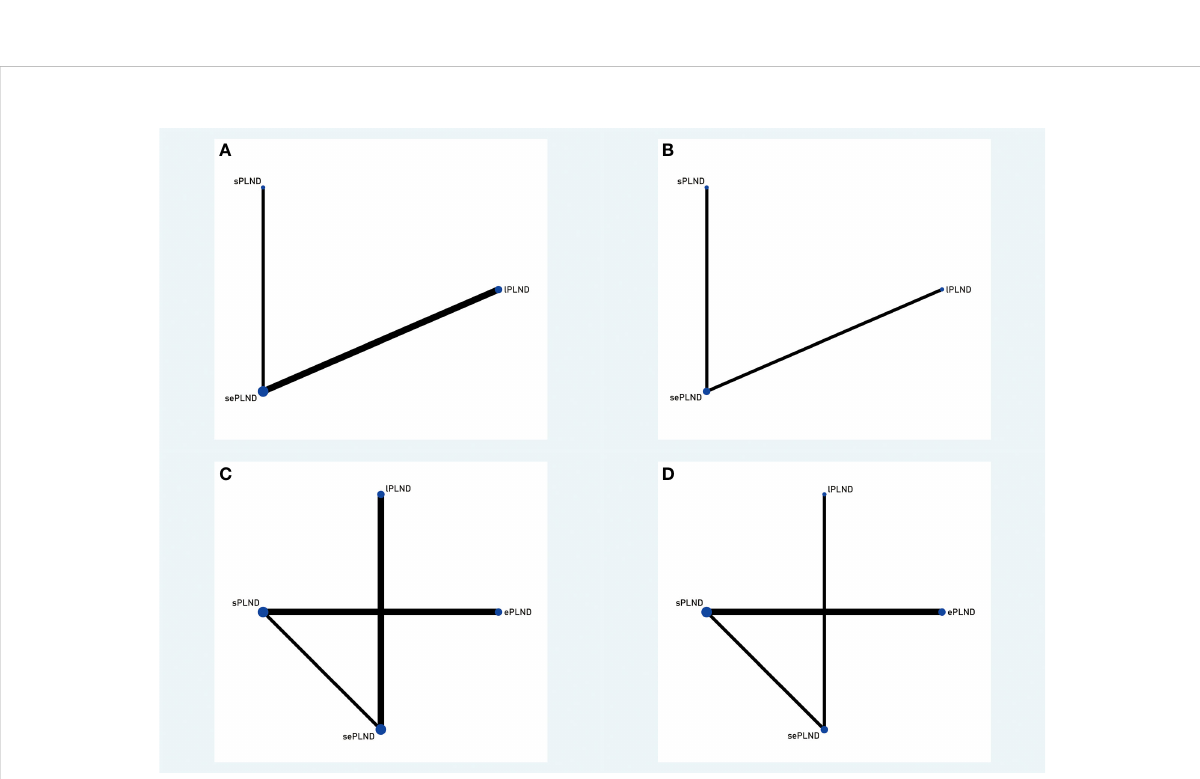
FIGURE 5 (A) Network plot showing the association of different PLND templates with the early Clavien-Dindo grade 5 complications rates in patients undergoing radical cystectomy. (B) Network plot showing the association of different PLND templates with the late Clavien-Dindo grade 5 complications rates in patients undergoing radical cystectomy. (C) Network plot showing the association of different PLND templates with the early Clavien-Dindo grade 3-4 complications rates in patients undergoing radical cystectomy. (D) Network plot showing the association of different PLND templates with the late Clavien-Dindo grade 3-4 complications rates in patients undergoing radical cystectomy. PLND, Pelvic lymph node dissection. lPLND, limited pelvic lymph node dissection. sPLND, standard pelvic lymph node dissection. ePLND, extended pelvic lymph node dissection. sePLND, super-extended pelvic lymph node dissection. Note: Lymph node dissection templates are represented by nodes and direct comparison trials between different templates are linked with a line. The area of the dot represents the sample size of each template and the width of the line corresponds the number of direct comparison